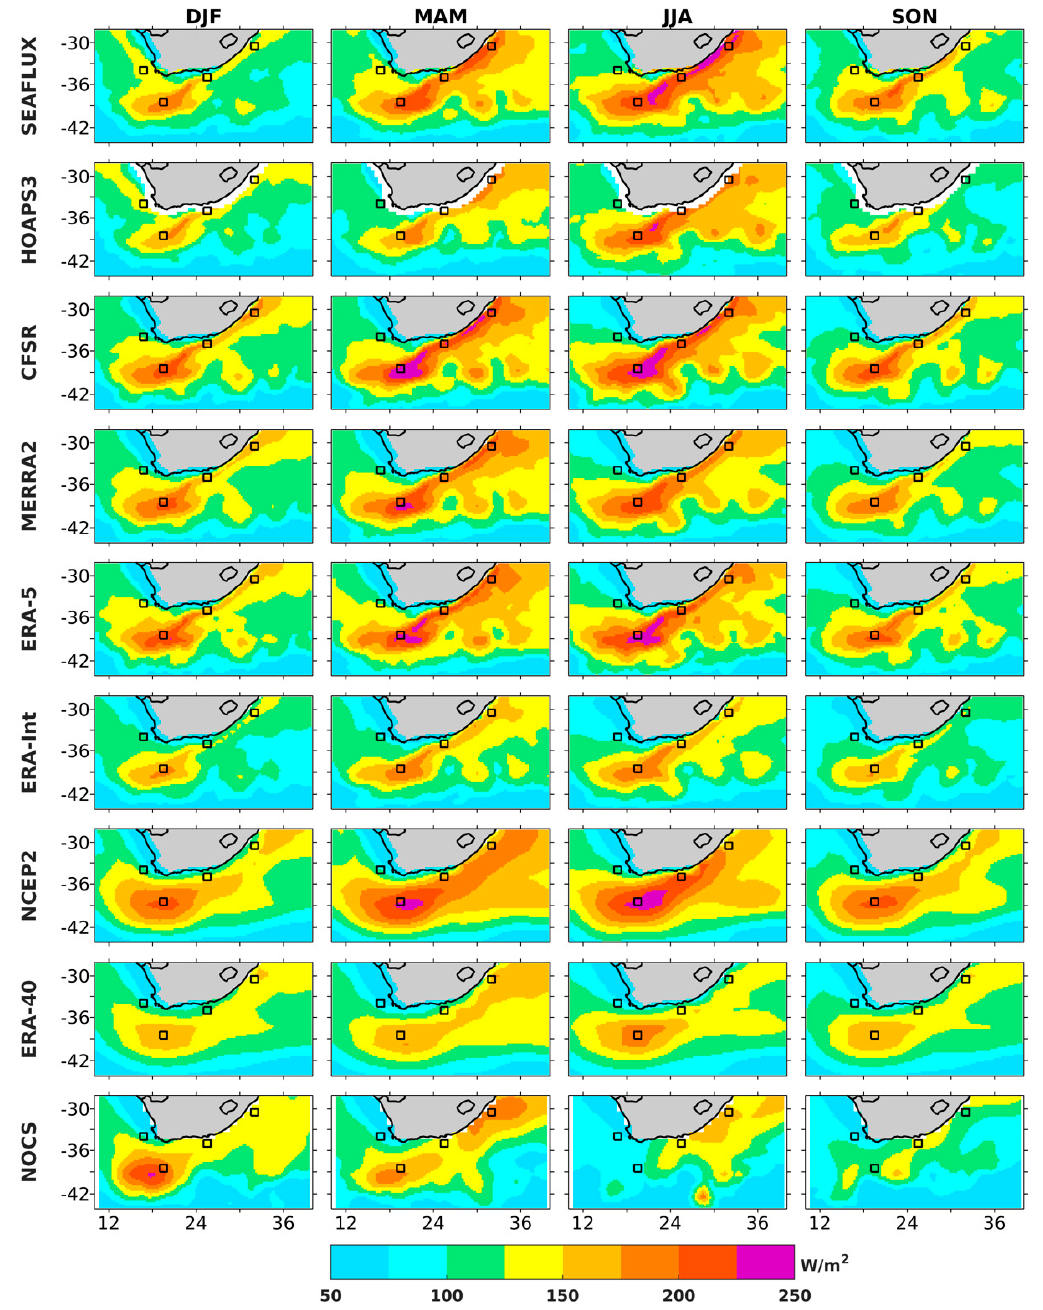
Figure 2. From top to bottom: seasonal average of latent heat flux (W / m 2 ) of SEAFLUX, HOAPS3, CFSR, MERRA-2, ERA-Interim, NCEP2, ERA-40 and NOCS. From left to right austral summer (December to February—DJF), austral autumn (March to May—MAM), austral winter (June to August—JJA), and austral spring (September to November—SON). Black squares represent the four locations taken for the study as in Figure 1, Agulhas Current o ff Durban, Agulhas Current o ff Port Elizabeth, Agulhas Retroflection and o ff Cape Town.